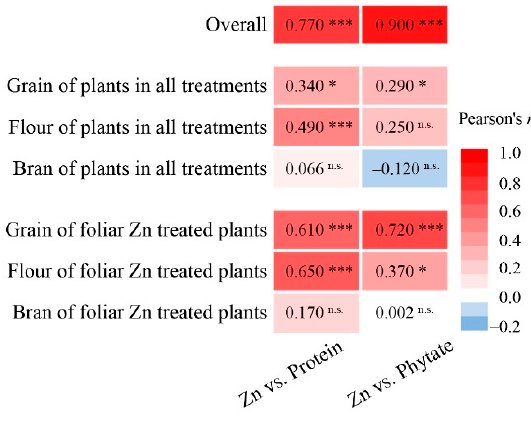
Figure 6. Pearson correlation coefficients between Zn and protein concentrations and between Zn and phytate concentrations in grain, bran, and flour of wheat plants from all treatments (control, foliar Zn, and Zn plus pesticides) or from foliar Zn spray treated plants (with and without pesticides). *, p < 0.05; ***, p < 0.001; n.s., not significant.